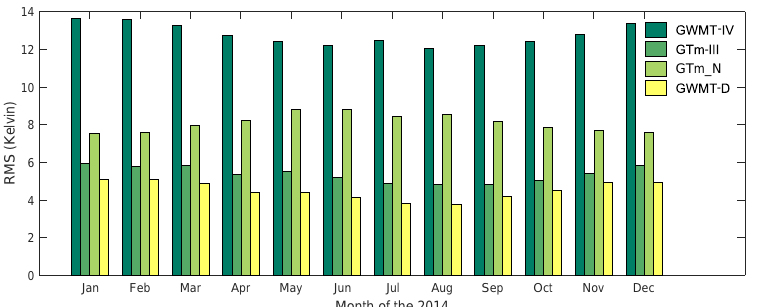
Figure 11. Monthly-mean RMSE of the T m from the four models and reference values is global radiosonde-derived T m in 2014.